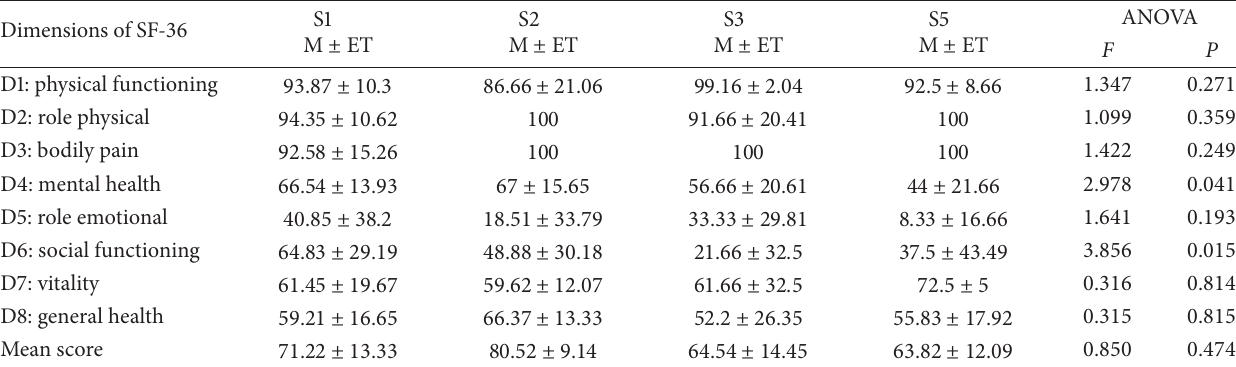
Table 2: Correlation between quality of life and